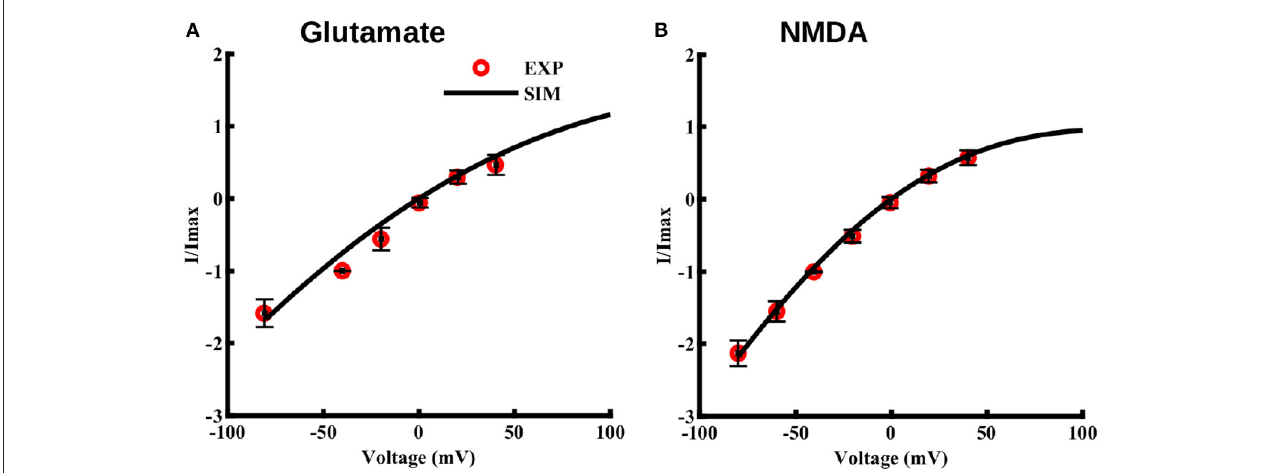
FIGURE3 Current-voltage relationship for NMDA and AMPA receptors in cortical astrocytes in the presence of glutamate and for NMDA receptors in presence of NMDA. I–V curve in the presence of 10 µ M glutamate (A) and 10 µ M NMDA (B) , both applied for 2 s at different holding potentials. The values of current are normalized with respect to the current obtained at –40 mV. Solid lines represent model fits and circles represent the experimental values from 11 independent experiments from Lalo et al. (2006).